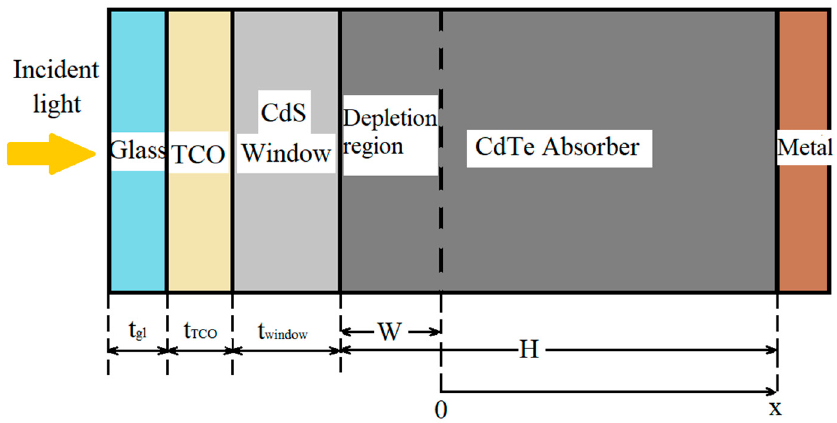
Figure 1. CdTe solar cell structure with a defined thickness for each layer, that is, t gl , t TCO , t window , and H represent the thickness of glass, TCO layer, CdS window layer, and CdTe absorber layer, respectively. x is defined as any position in the neutral region, thus x = 0 is set to be at the depletion region edge, and x = H − W at the metal back contact.